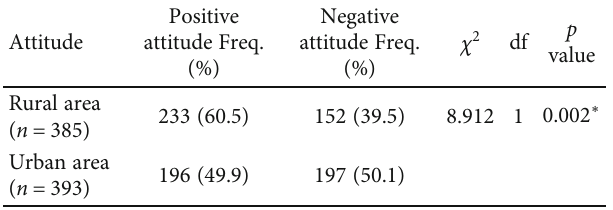
Table 3: Participants appropriate knowledge of tuberculosis. Table 4: Attitude scores of respondents to tuberculosis